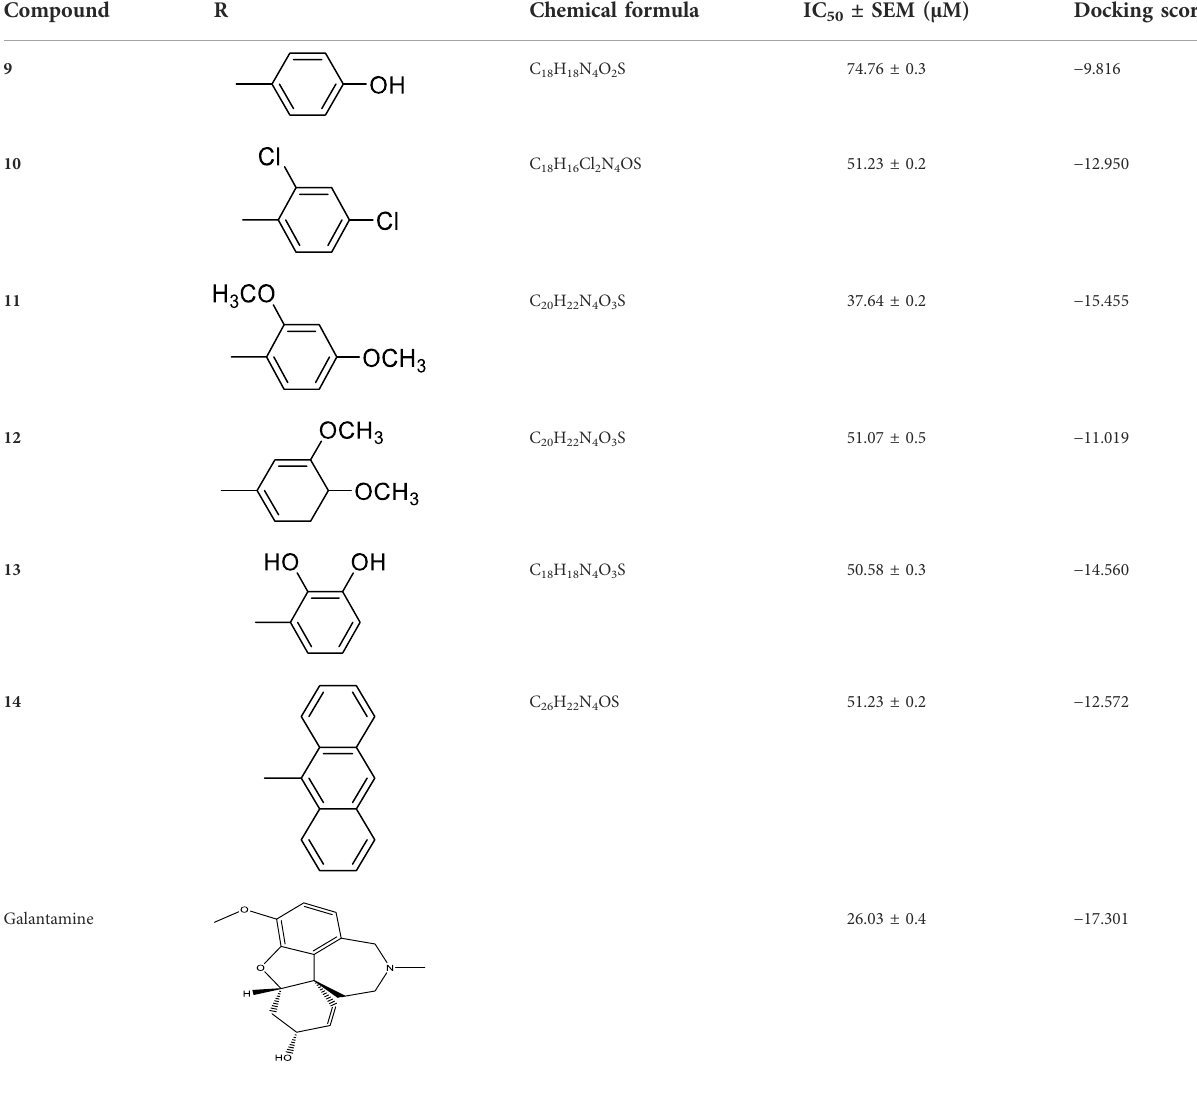
TABLE 1 Inhibitory activities of 2-mercaptobenzimidazole hydrazone derivatives (9 – 14) against AChE.